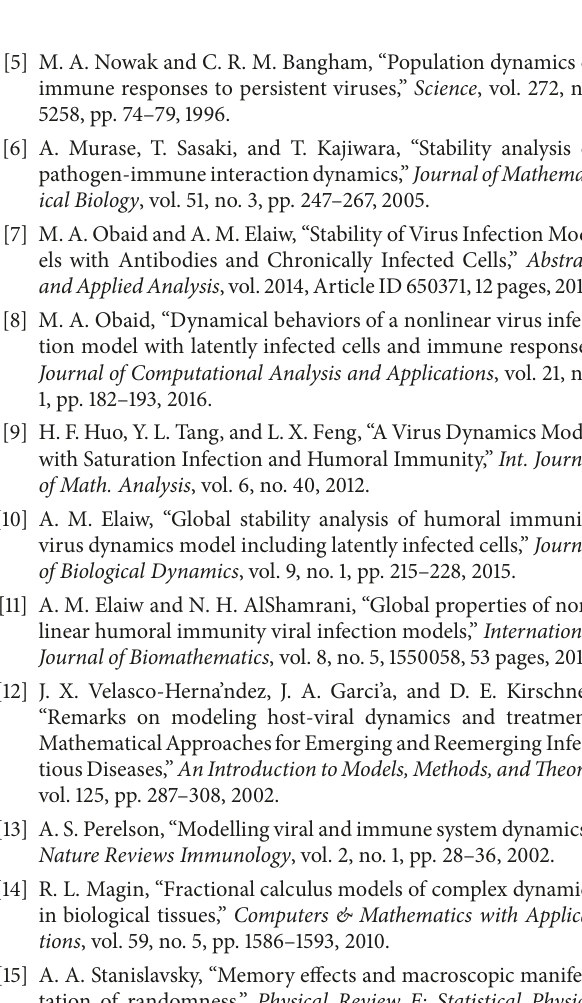
Figure 3: Stability of the infection equilibrium with humoral immunity 𝐸 2